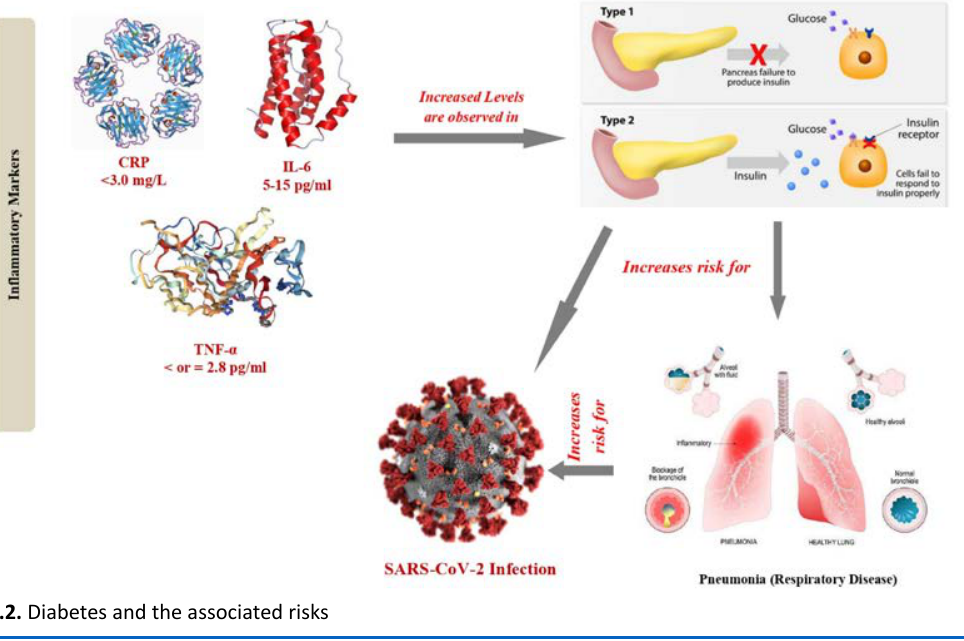
Fig.2. Diabetes and the associated